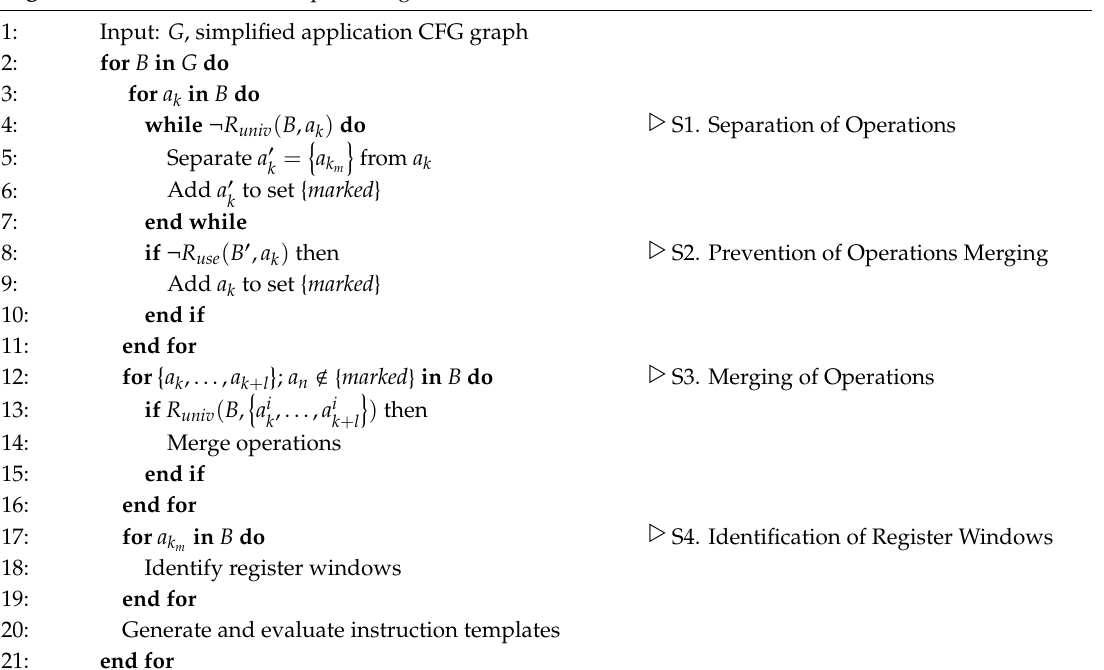
Algorithm 1 GNSS-ISE development algorithm. Algorithm 1. GNSS-ISE development algorithm.